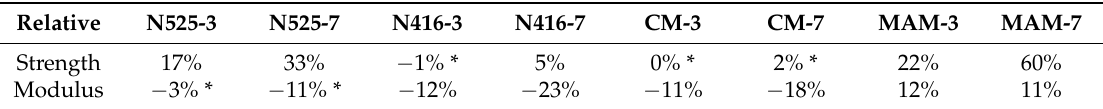
Table 2. Elongation at break with standard deviations. Insignificant changes compared to NC at 95% confidence level are marked with an asterisk (*).